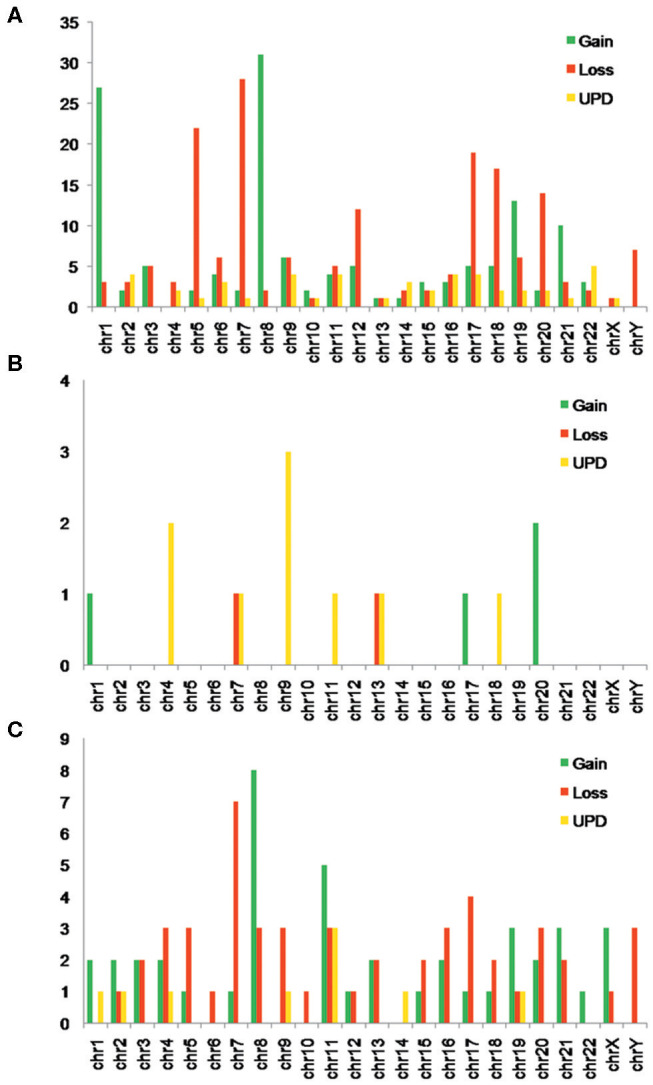
(A) Number of myelodysplastic syndrome (MDS) patients with different types of single-nucleotide polymorphism array (SNP-A) abnormalities in each chromosome. (B) Number of myeloproliferative neoplasm (MPN) patients with different types of SNP-A abnormalities in each chromosome. (C) Number of acute myeloid leukemia (AML) patients with different types of SNP-A abnormalities in each chromosome.